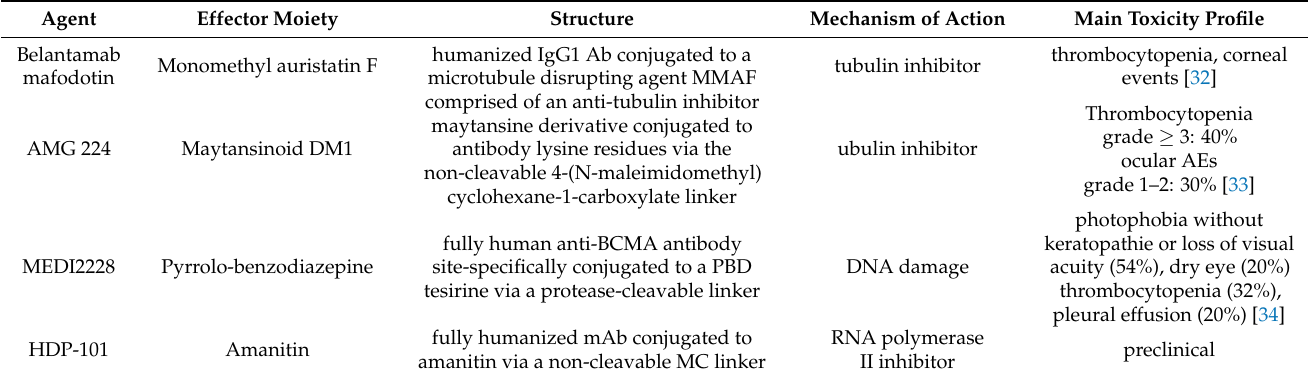
Table 2. Main characteristics of different ADCs and their toxicities in multiple